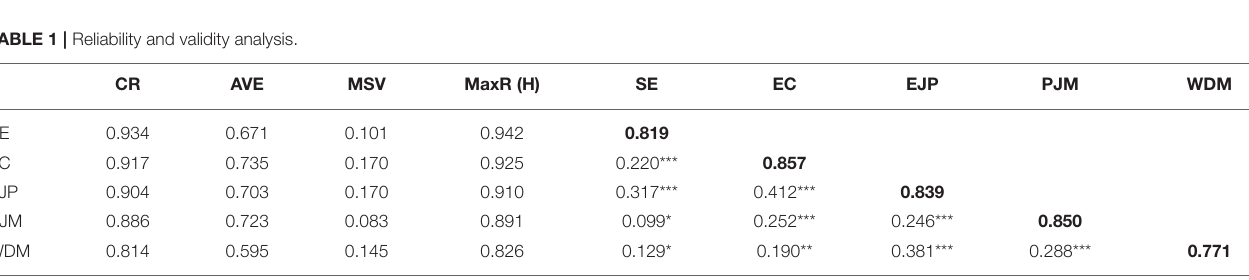
TABLE 1 | Reliability and validity